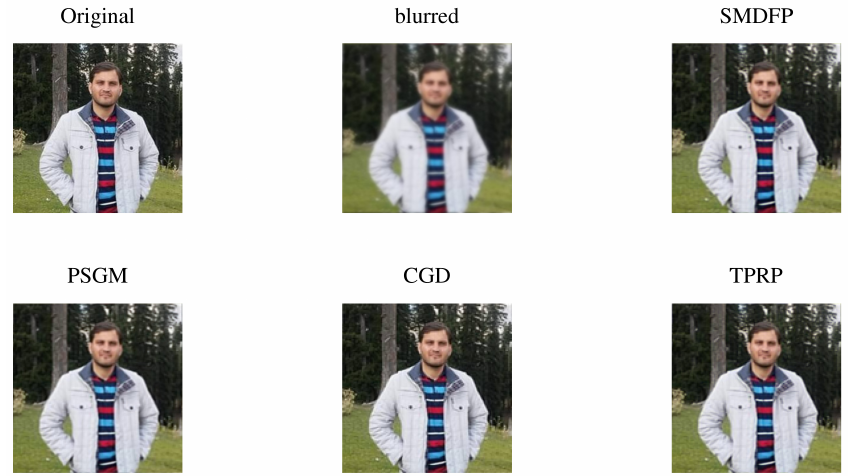
Figure 9. Comparison of the original image, blurred image, SMDFP image, CGD image, PSGM image, and TPRP image for the number of iterations, CPU time, MSE, and SNR.